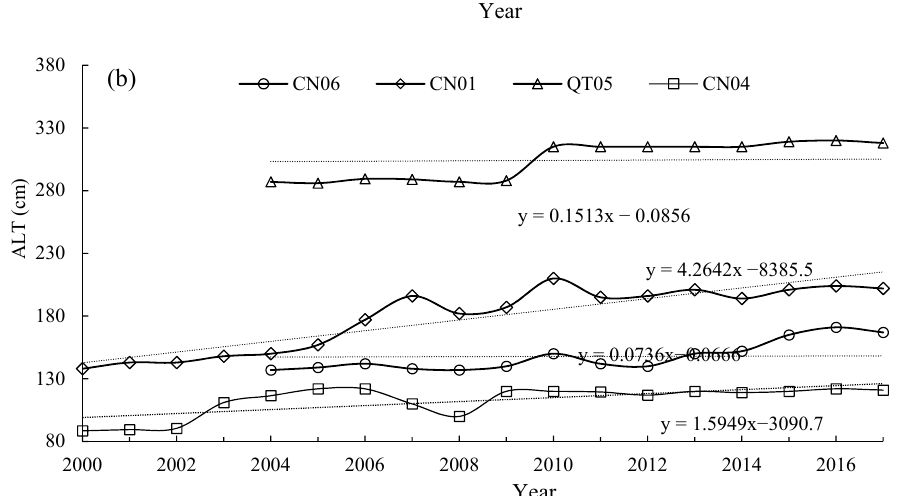
Figure 7. The annual change in averaged active layer thickness (ALT) during 1981–2017 ( a ) and the ALTs at four observation sites ( b ) along the Qinghai–Tibet ALTs at four observation sites ( b ) along the Qinghai–Tibet Highway.